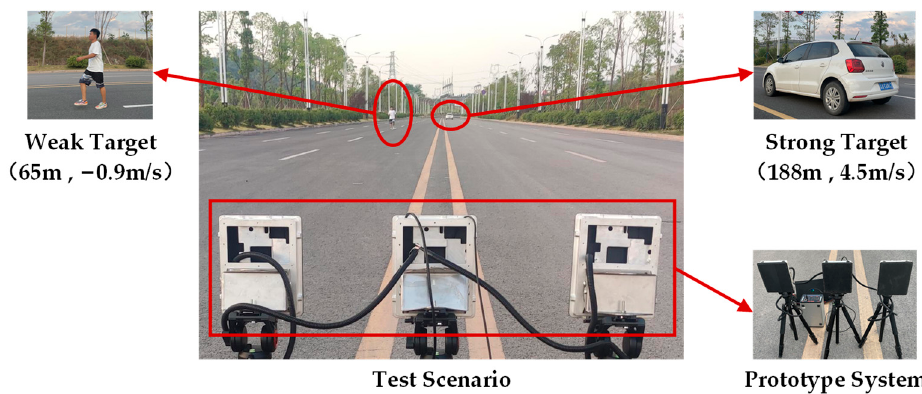
Figure 17. The prototype system and the test scenario consisting of a vehicle and a pedestrian.